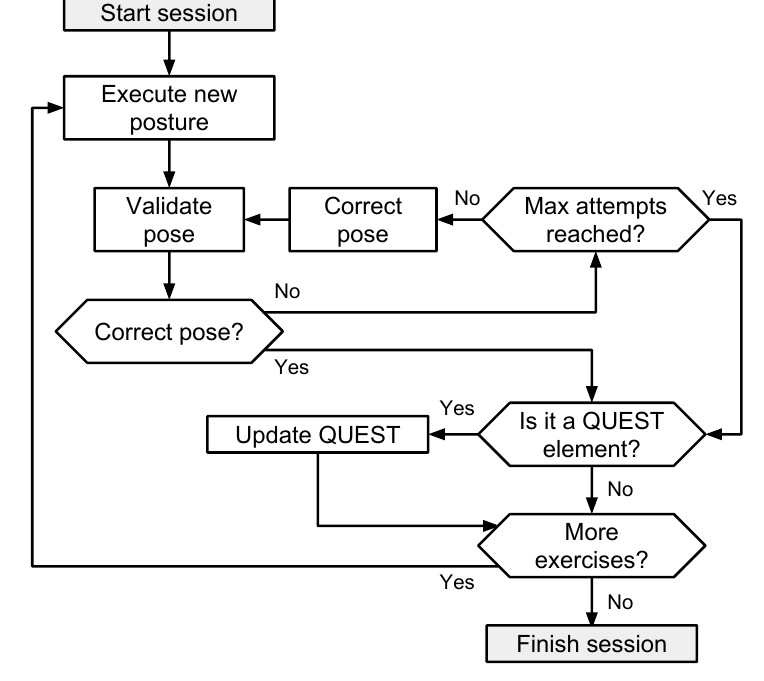
Figure 3. NAOTherapist session execution cycle.